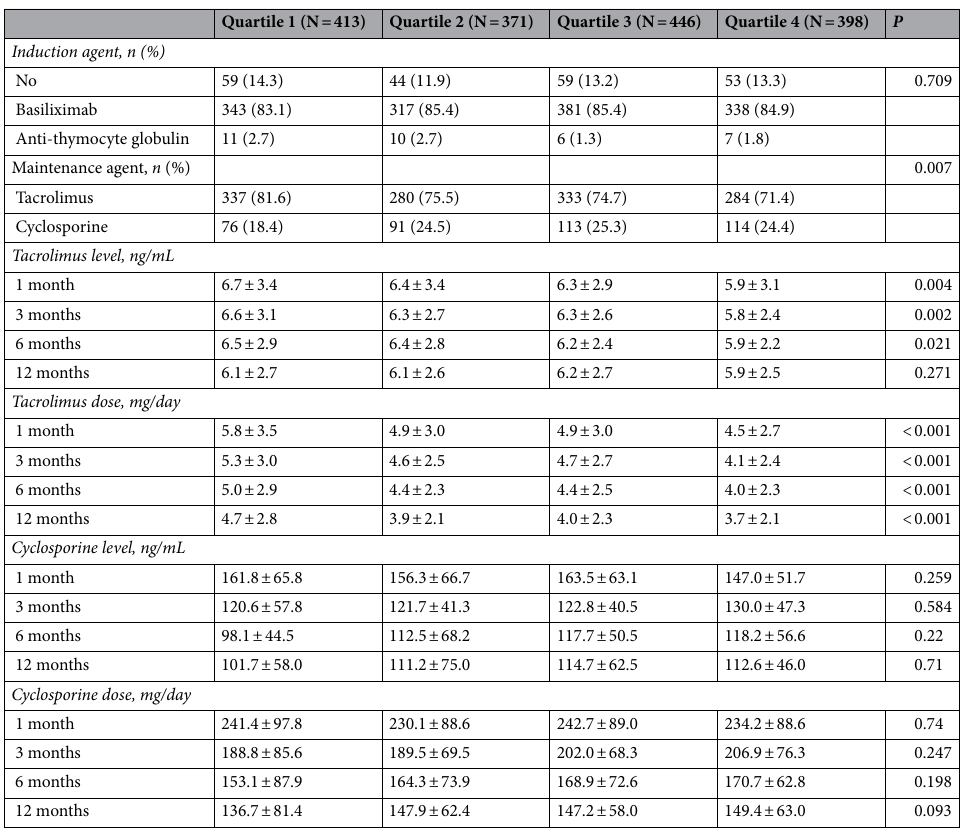
Table 2. Immunosuppression, stratified by sex-specific serum bilirubin